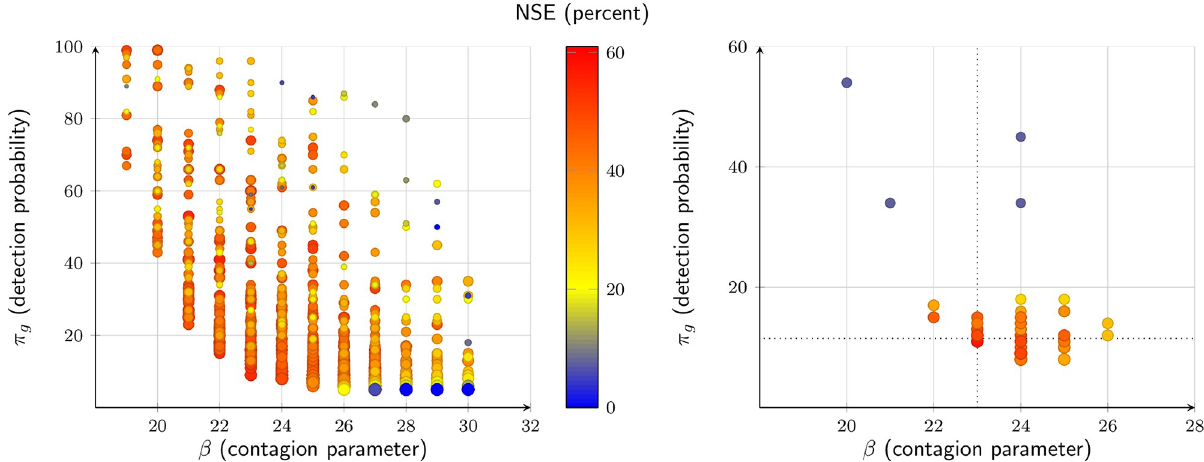
Fig 5. Parameter search. (a) First round. (b) Second round. Each dot corresponds to a simulation (5 realizations each in the first round, 100 realizations each in the second round). The top-50 paramater configurations made it to the second round. The color corresponds to the simulation’s Nash Sutcliffe Efficiency value on weekly new cases. Only realizations with positive NSE are depicted.